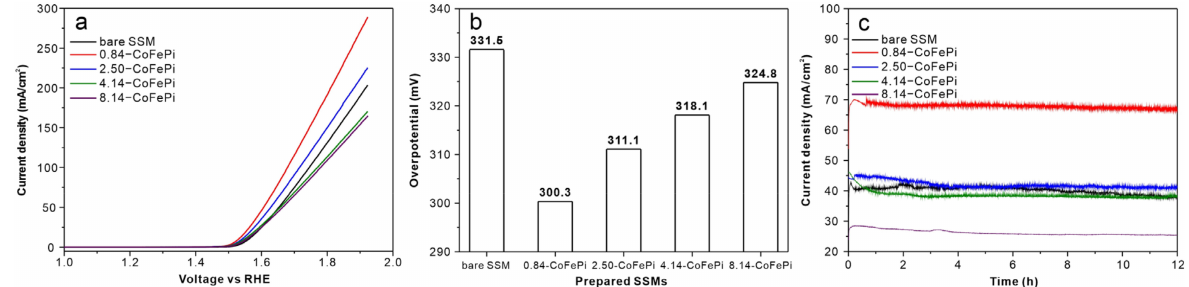
Figure 5. Electrochemical (OER) analysis of all hydrothermally synthesized OER catalysts, and bare SSM: ( a ) LSV curves examined with the scan rate of 10 mVs − 1 in 1 M KOH electrolyte, ( b ) The overpotentials at current density of 10 mAcm − 2 , and ( c ) Bulk electrolysis plotted from 12 h of hydrolysis at the voltage of 1.624 V vs. RHE in 1 M KOH electrolyte.